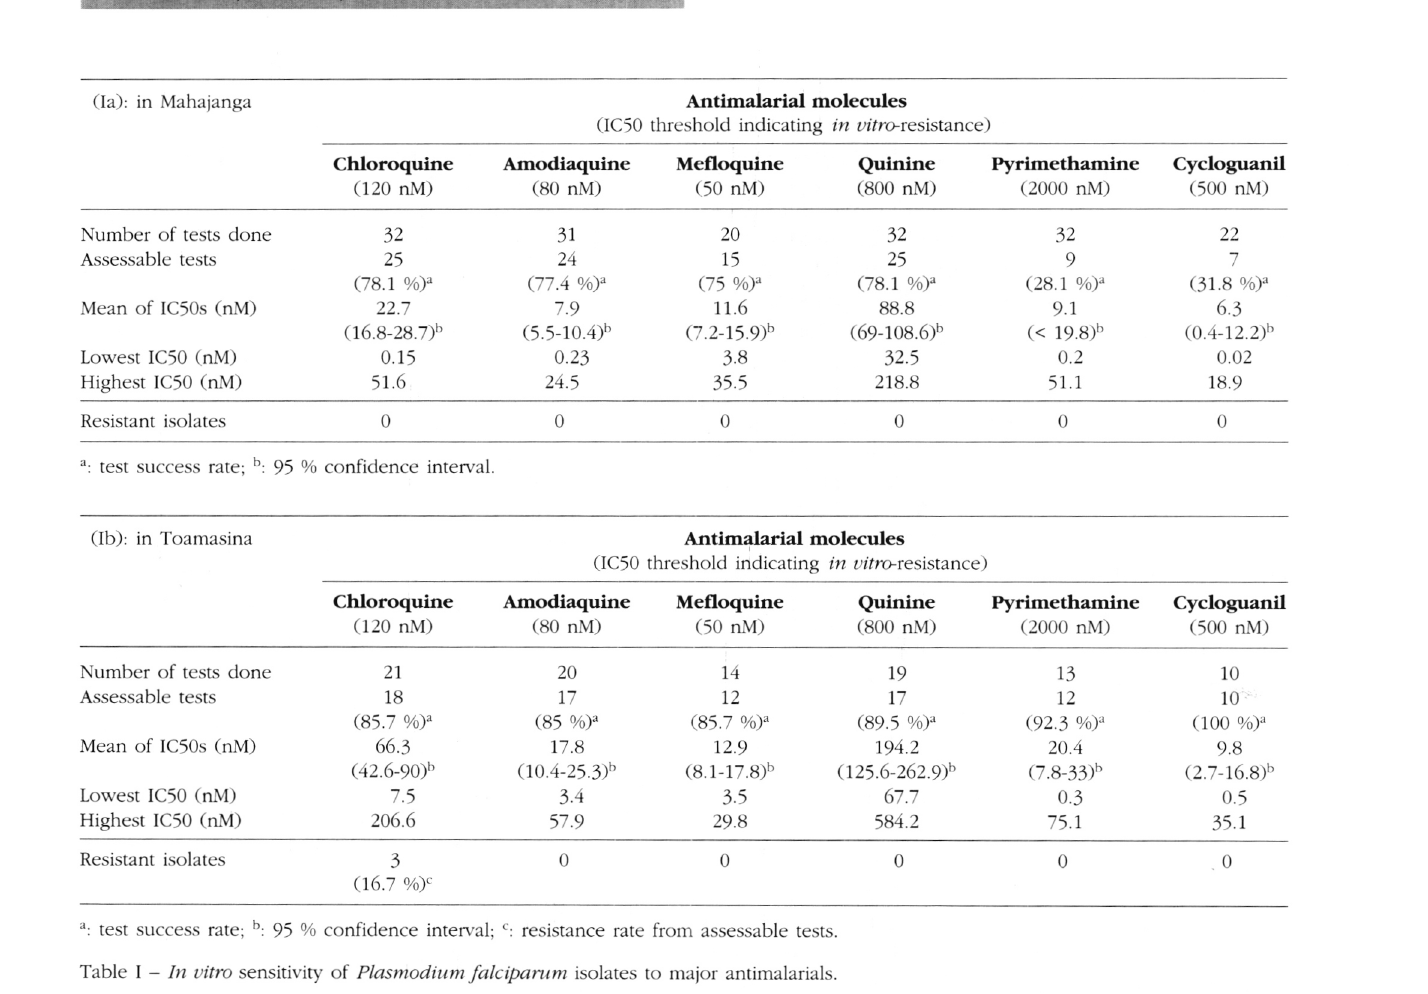
Table I - In vitro sensitivity of Plasmodium falciparum isolates to major